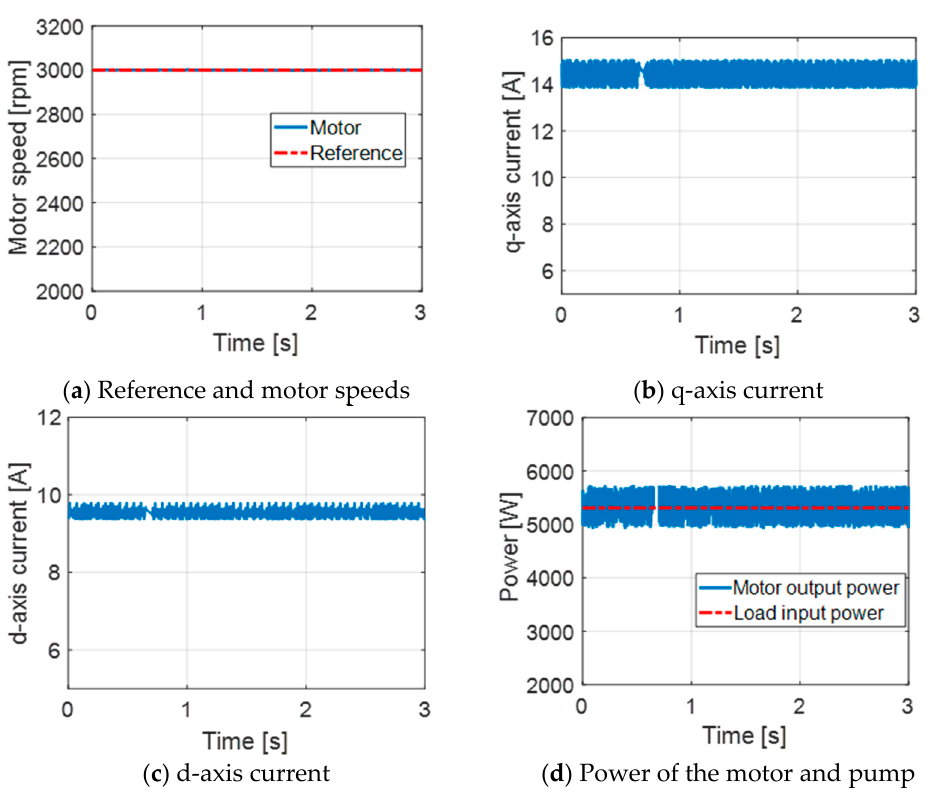
Figure 14. Measured performance of SynRM at rated condition.